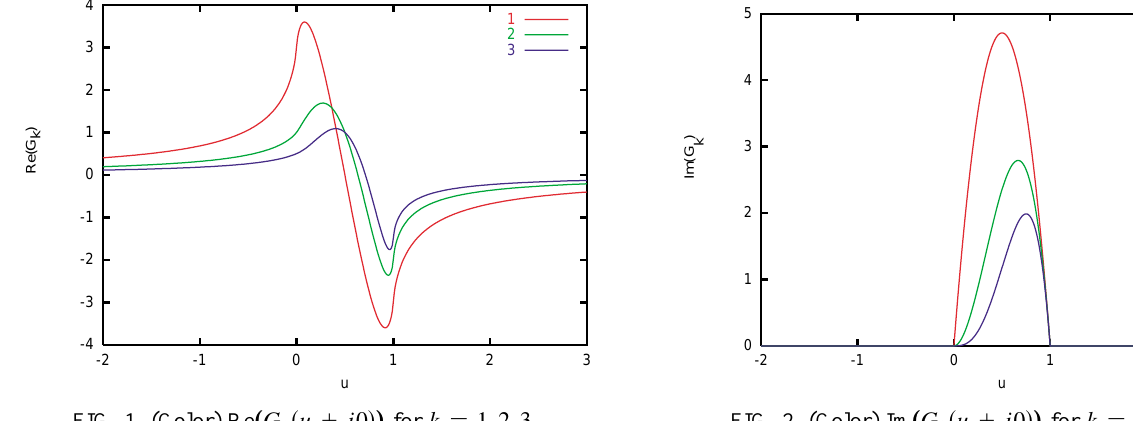
FIG. 1. (Color) Re (cid:1)(cid:1)(cid:1) G k (cid:1) u 1 i 0 (cid:2)(cid:2)(cid:2)(cid:2) for k (cid:1) 1, 2, 3 . FIG. 2. (Color) Im (cid:1)(cid:1)(cid:1) G k (cid:1) u 1 i 0 (cid:2)(cid:2)(cid:2)(cid:2) for k (cid:1) 1, 2, 3 . 044202-6